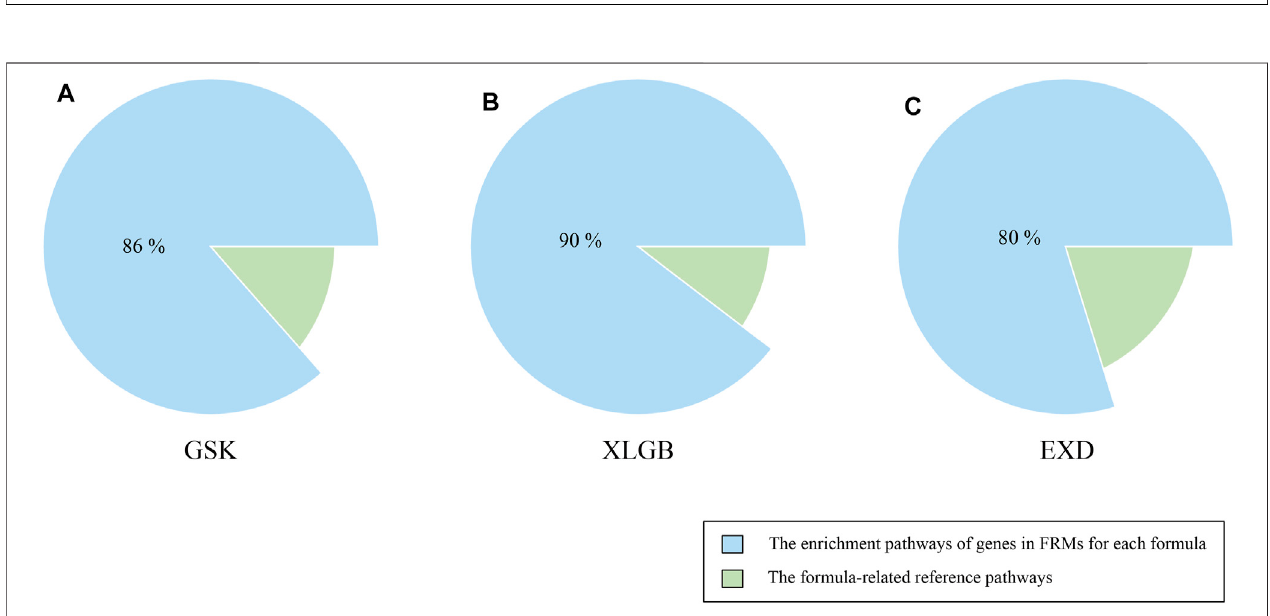
FIGURE 8 | Validation of FRMs. The proportion of the enrichment pathways of genes in FRMs for GSK (A) , XLGB (B) , and EXD (C) to corresponding reference pathways. The formula-related reference pathways were de fi ned as selecting the intersection of the target gene and pathogenic gene enriched pathways.